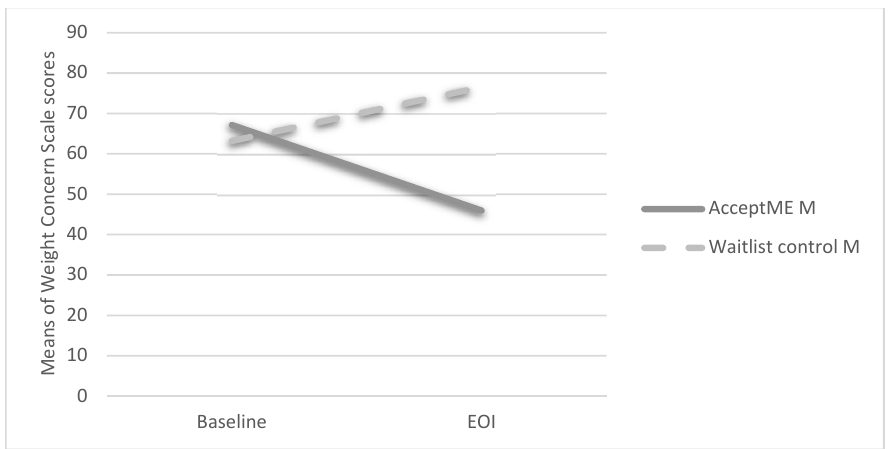
Figure 2. Group by Time Interaction of Weight Concern Scale scores. Note: EOI = End-of-intervention time point of assessment; M = Mean value.